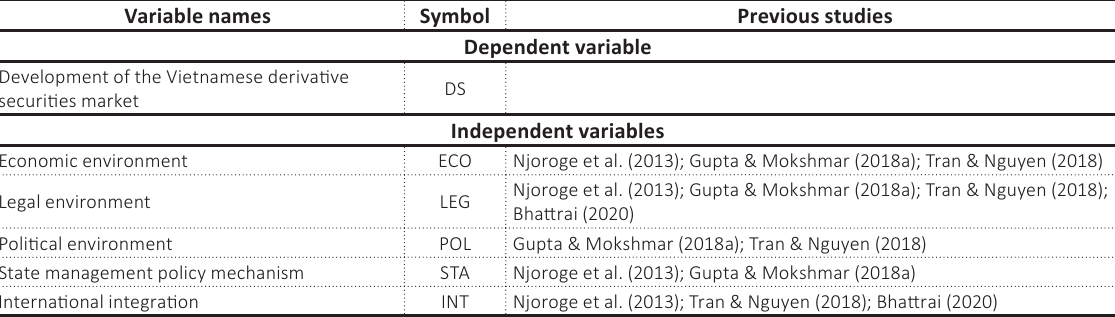
Table 1. Variable names and previous studies in the